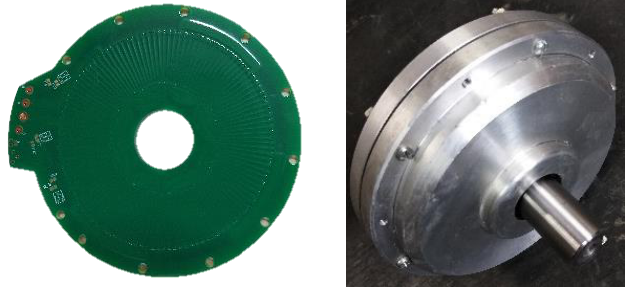
Figure 15. Improved PCB stator and prototype.